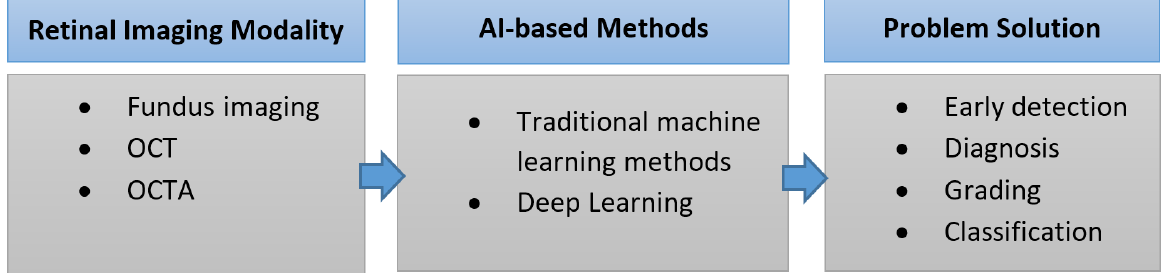
Figure 2. Analysis of retinal images.